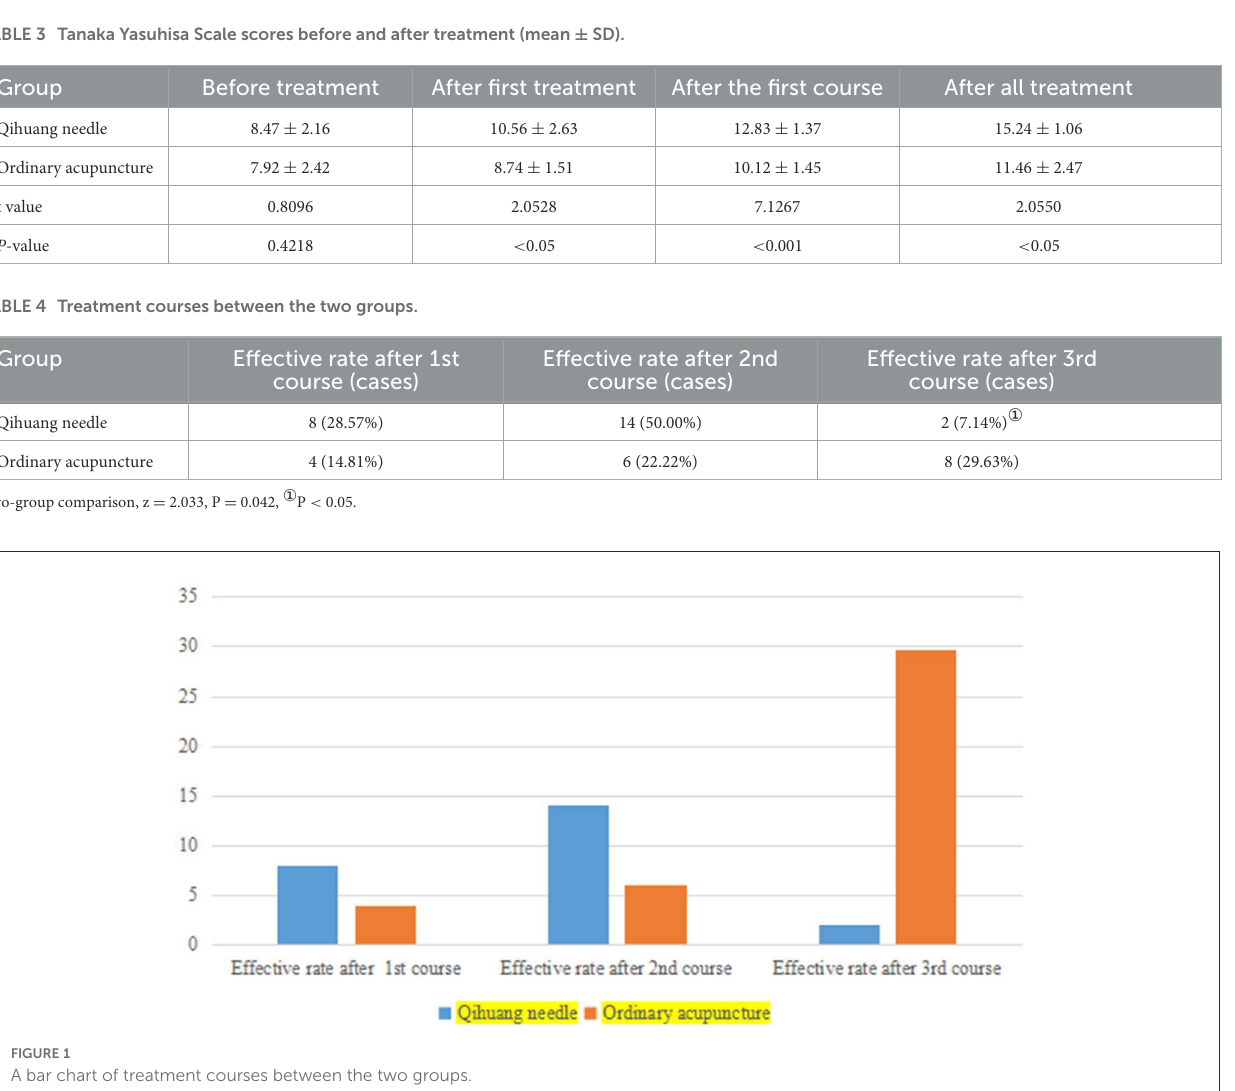
group and the general acupuncture group, respectively, and 50.00% (14/28) and 22.22% (6/27) after two courses of treatment, respectively. The effectiveness rates of the first and second courses of treatment in the Qihuang acupuncture group were higher than those in the general acupuncture group. The duration of treatment was significantly shorter in the Qihuang acupuncture group than in the control group ( P < 0.05) (Table 4 and Figures 1, 2) (Efficacy rate = the number of patients treated effectively / total number of patients). It has been shown that the treatment effect of Qihuang